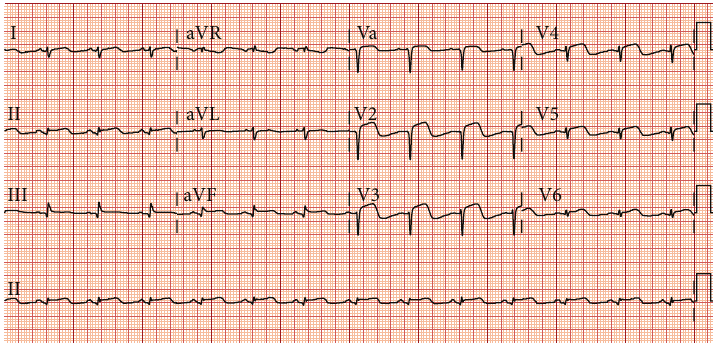
Figure 3: ECG on the third day of admission shows diffuse convex ST-segment elevations in leads V1 to V6, II, III, and